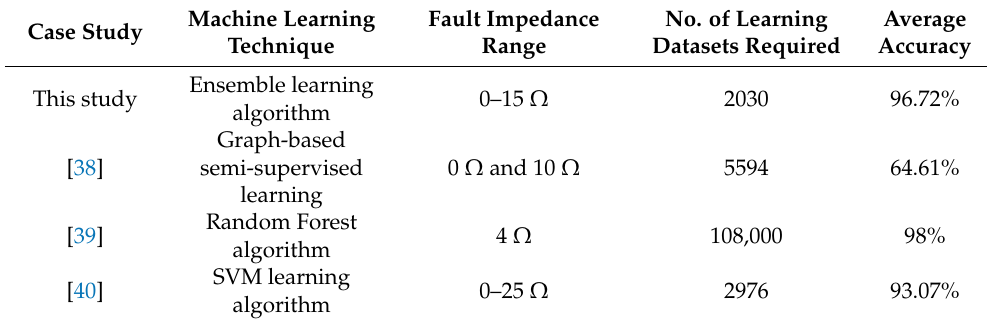
Table 10. Comparative results between the proposed method and other studies.